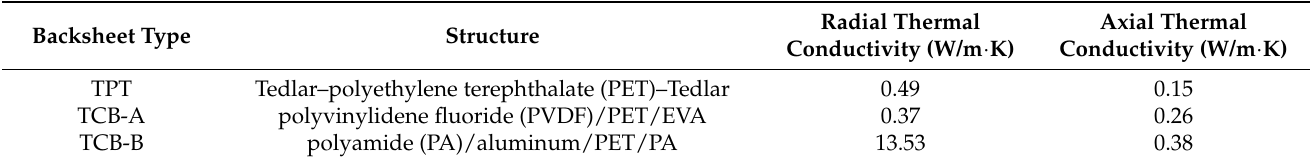
Table 1. Thermal conductivities of three different types of backsheet material measured at 24 ◦ C [21]. Backsheet Type Structure